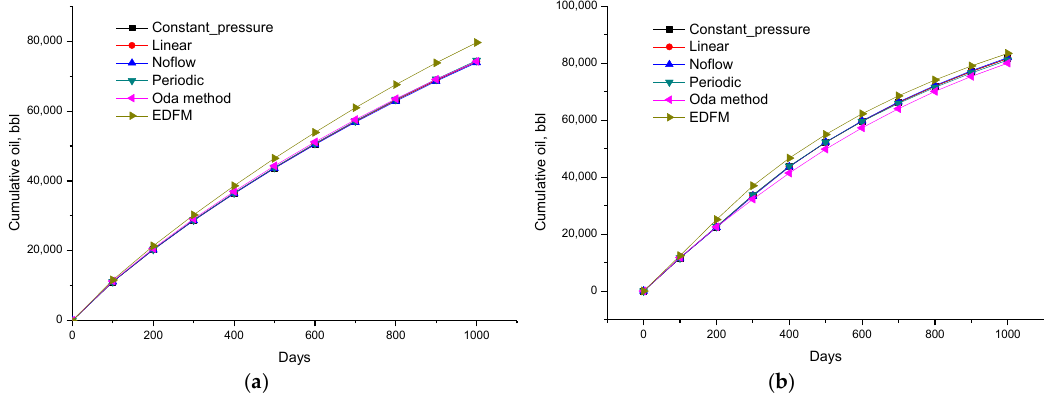
Figure 6. Simulation results for different models. ( a ) water flooding; ( b ) gas flooding.